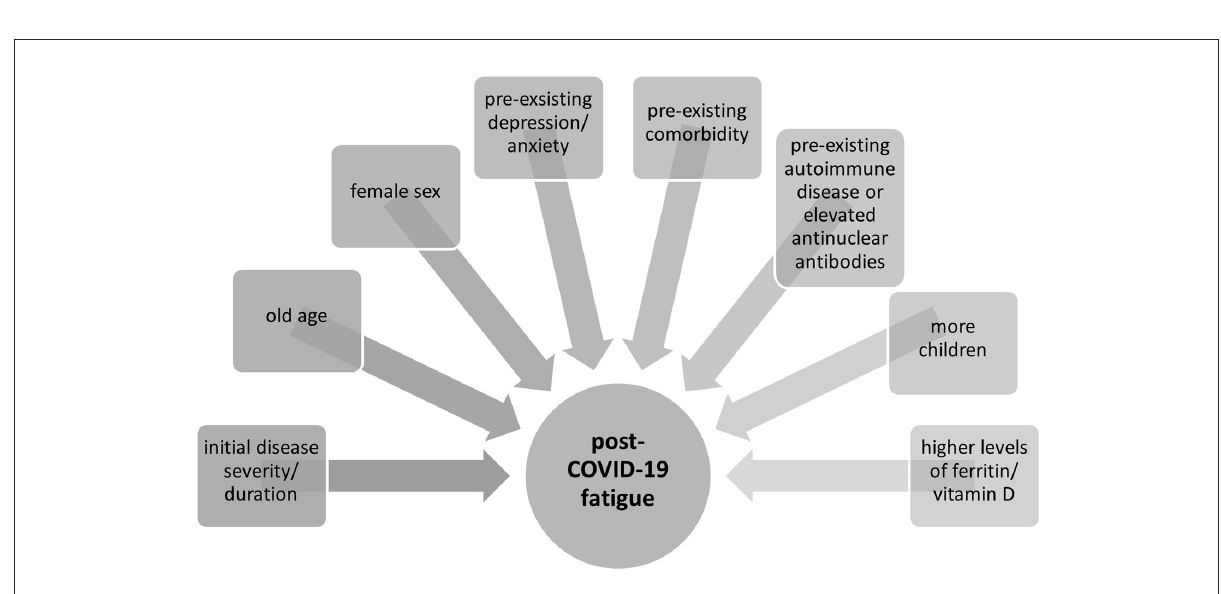
FIGURE3 Etiology and risk factors of post-COVID-19